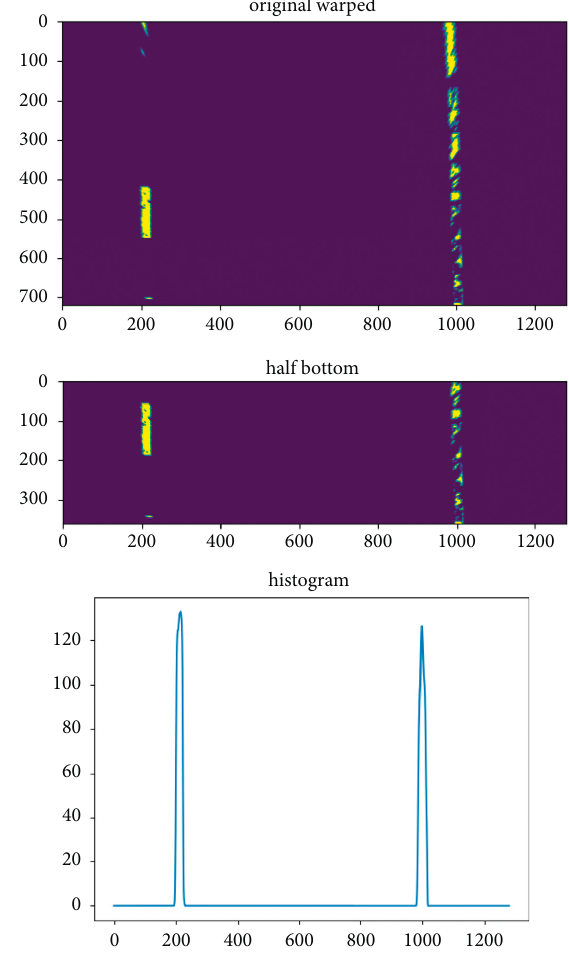
Figure 11: Finding peak of